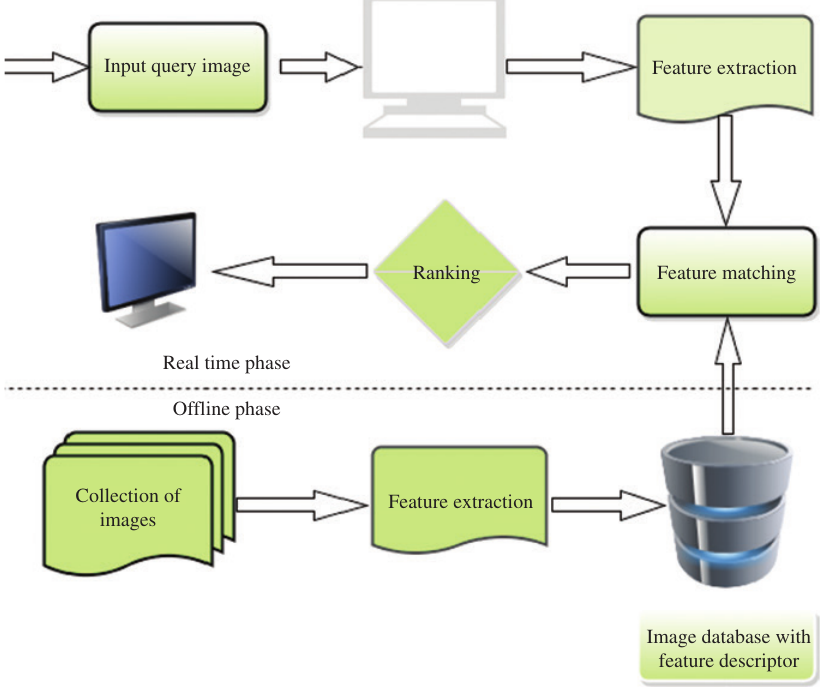
Figure 4: Architecture of Proposed